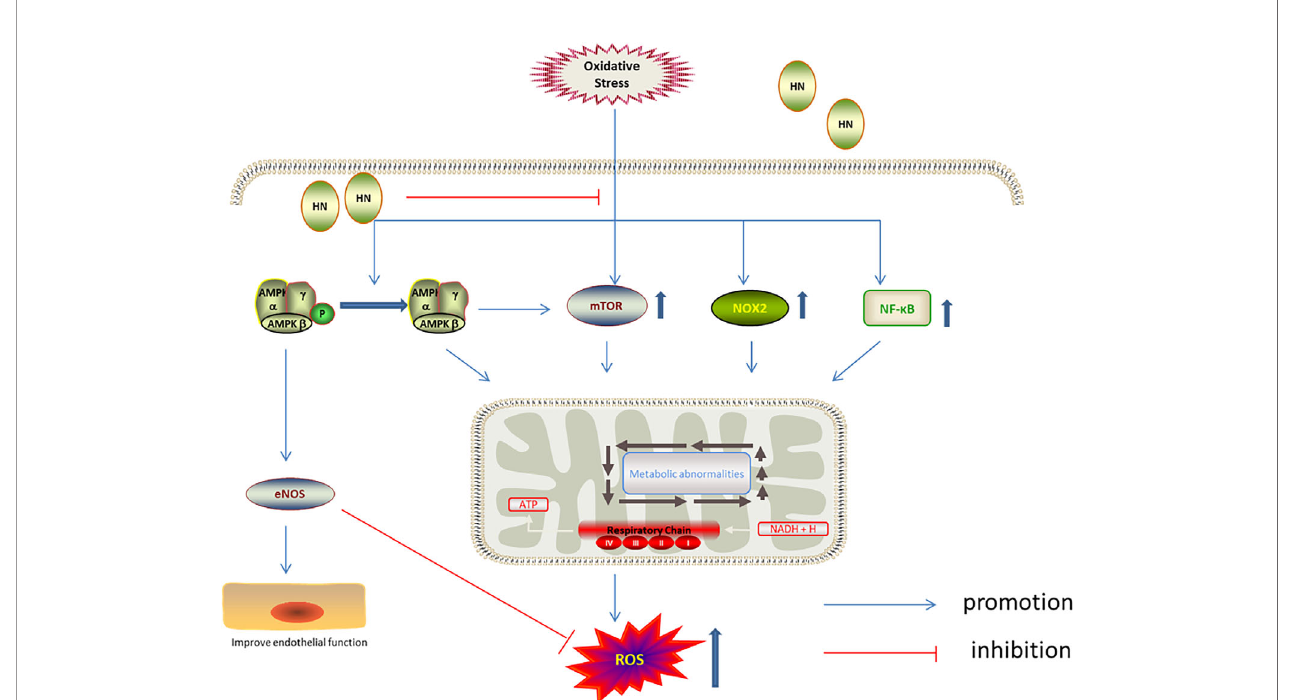
FIGURE 5 | Regulation of HN on AMPK/mTOR under oxidative stress. HN up-regulates the phosphorylation of AMPK, activates eNOS, inhibits mTOR, NOX2 and NF- k B, to reduce the production of ROS, improve endothelial